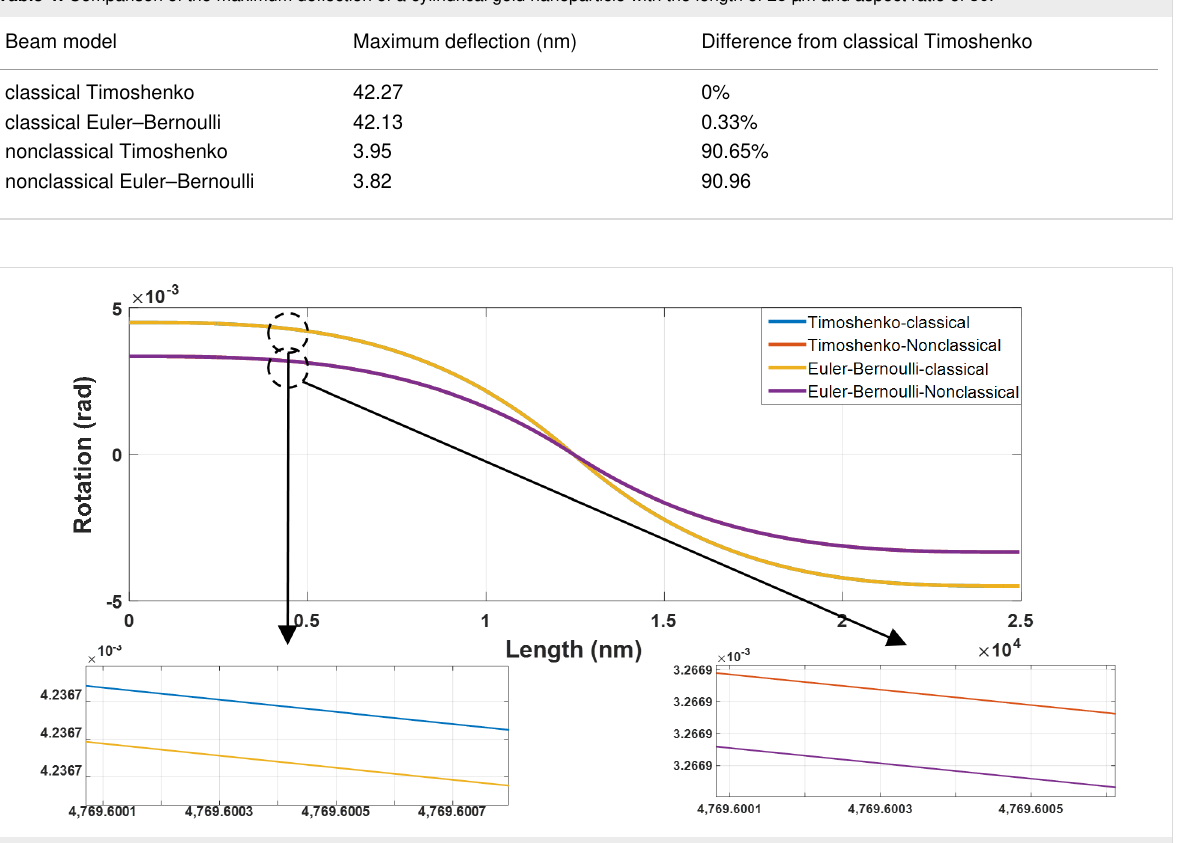
Figure 8: Classical and nonclassical modeling of the rotation angles of a cylindrical gold nanoparticle (length = 25 µm and aspect ratio = 30) based on the four models of classical Euler–Bernoulli, classical Timoshenko, nonclassical Euler–Bernoulli and nonclassical